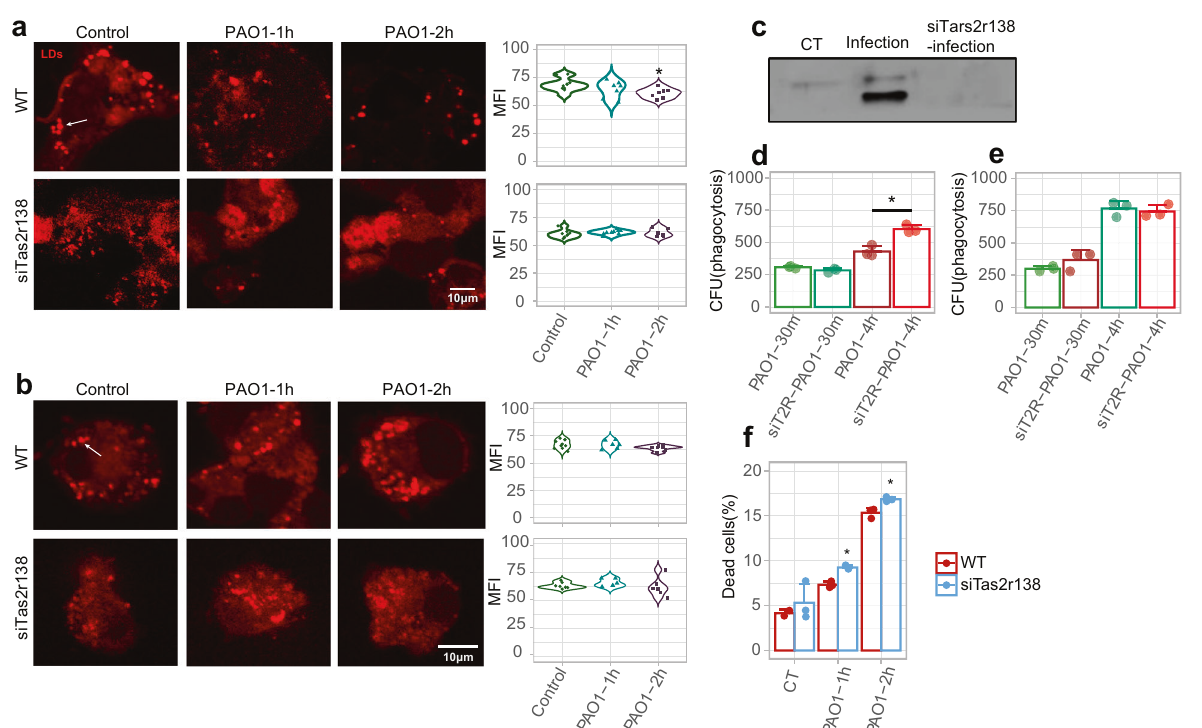
Fig. 2 TAS2R138 was involved in LDs reduction. WT or Tas2r138 siRNA-transfected AMs and neutrophils were infected with PAO1 (MOI: 5:1) for 2 h. a , b The LDs (stained by Nile red) expression was detected by immuno fl uorescence imaging in neutrophils ( a ) (arrows showed the typical LDs) and AMs ( b ). The mean fl uorescence intensity (MFI) form 6 – 10 images were counted on the right by Image J. c The LDs were isolated from WT or infected and Tas2r138 siRNA-transfected neutrophils and the TAS2R138 on the LDs was detected by western blotting. e , f AMs and neutrophils were infected with PAO1 (MOI: 5:1) for 30 min or 4 h. The phagocytosis and clearance of PAO1 were counted by CFU. WT or Tas2r138 siRNA-transfected neutrophils were infected with PAO1 (MOI: 5:1) or AHL-12 (100 µM) stimulated for 2 h. The dead cells were